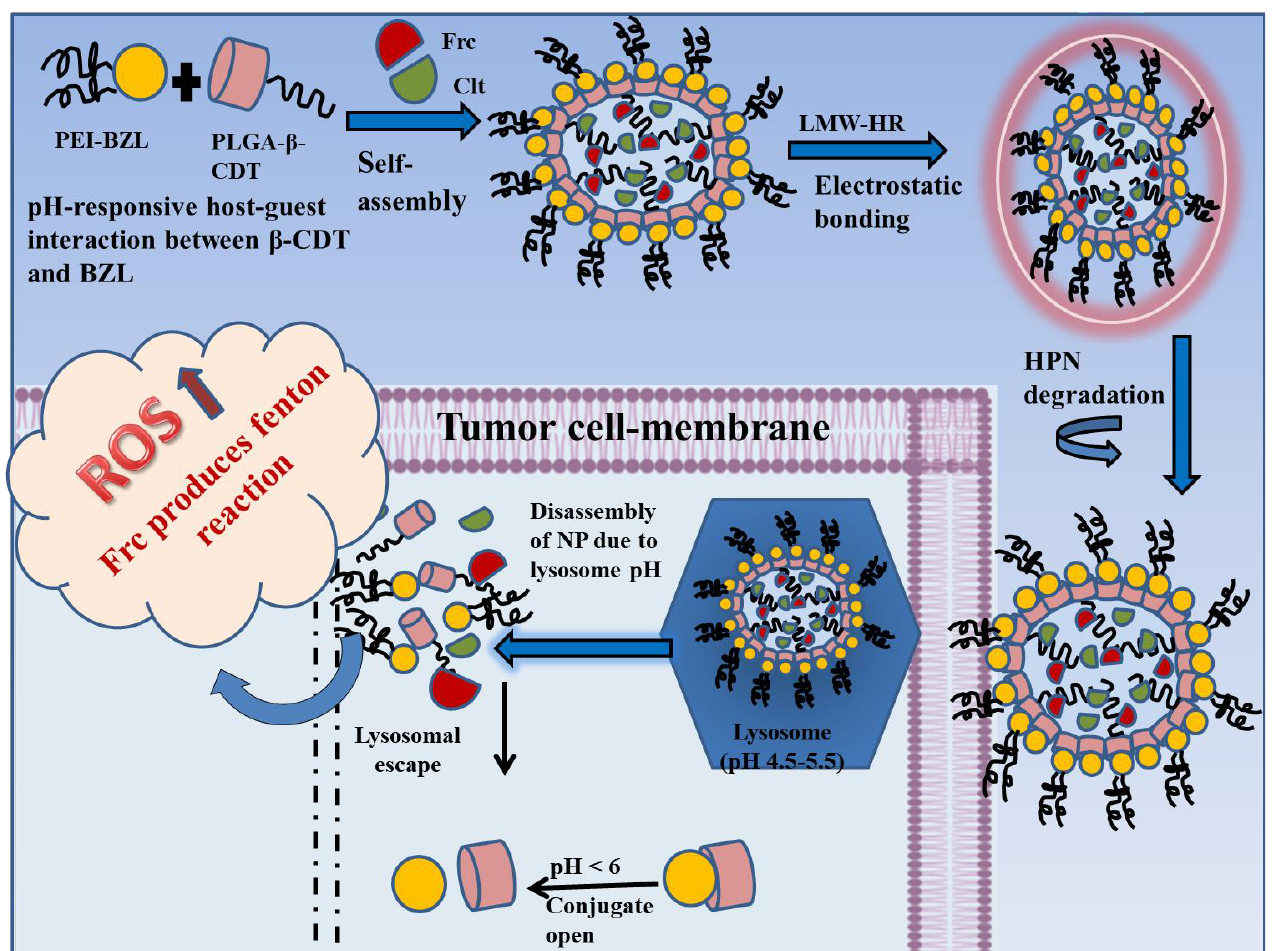
Figure 4. The development and mechanism of action of amphiphilic, pH-sensitive, LMW-HR-coated nanoparticles (PPL-HR NP), containing ferrocene (Frc) celastrol (Clt). The % DL (drug loading) of Fcr and Clt in PPL-HR NPs was found to be 2.83% and 3.08%, respectively and the % EE was 90.73% for Fcr and 98.56% for Clt. High % DL and % EE were credited to the hydrophobic nature of Fcr and Clt, which promoted loading of both drugs inside the hydrophobic PLGA core of the NPs. To verifying the action of Fcr, crystal violet (CV) was used, and solutions of CV, CV+H2O2 and CV+H2O2+Fcr were prepared using different concentrations. The solu- tions were kept at room temperature for 90 min and then their absorbances were meas- ured at 580nm using a UV-spectrophotometer. The absorbance value of CV reduced after the addition of Fcr, indicating that a Fenton reaction occurred and Fcr had converted H 2 O 2 to HO·. Tumor cells have a high level of H 2 O 2 ; thus, a steady source of providing H 2 O 2 for Fenton reactions. The beneficial conversion ability of Fcr guarantees H 2 O 2 catalysis into HO·, thus synergizing with the tumor-killing ability of Clt. Further, to check the in vitro release of Fcr and Clt due to the breaking of the β -CDT- BZL bond at low intra-cellular pH, a release study was performed at different pH. At pH 7.4, the pH of blood and normal tissues, the cumulative release of Fcr from PPL-HR NP was about 31.24 ± 2.47% at the 48th hour and it reached 85.89 ± 2.71% in 48 h at pH 5.8, i.e., the pH of endosomes. Up to 80.23 ± 3.49% Clt was released in 48 h at pH 5.8, while only 23.58 ± 3.81% was released at pH 7.4 at the same time point. This rapid release of the